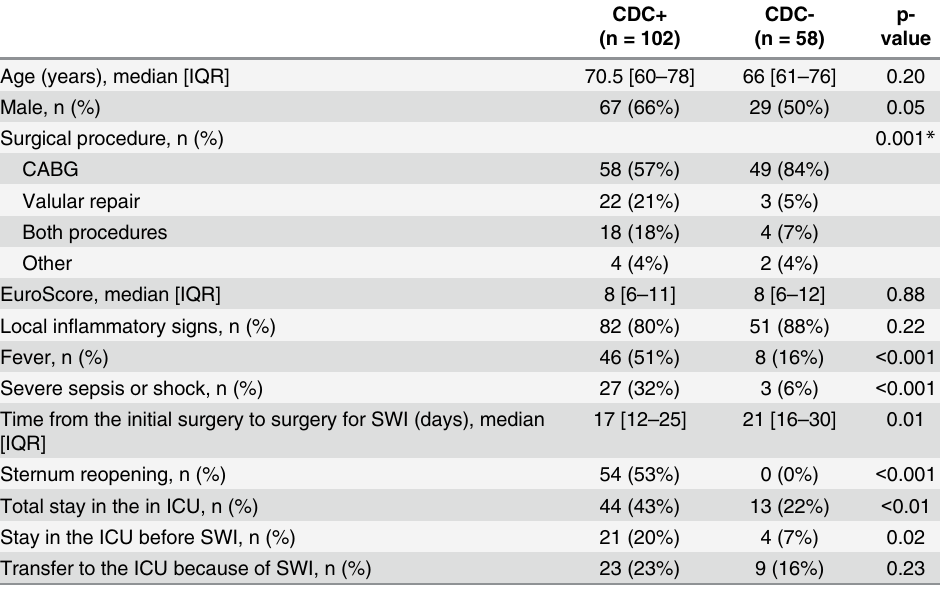
Table 1. Initial Presentation of 160 Patients with Sternal Wound Infection Requiring Reoperation after Cardiac Surgery.